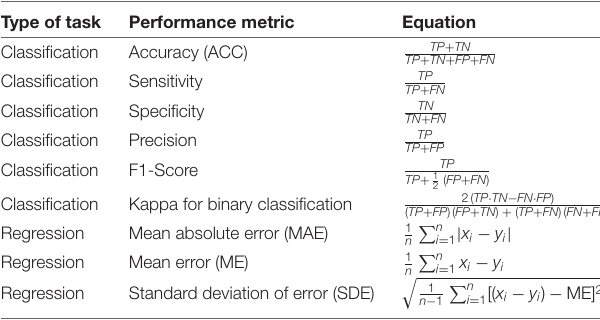
TABLE 1 | Performance metrics used to examine the performance of ML models for regression and classification